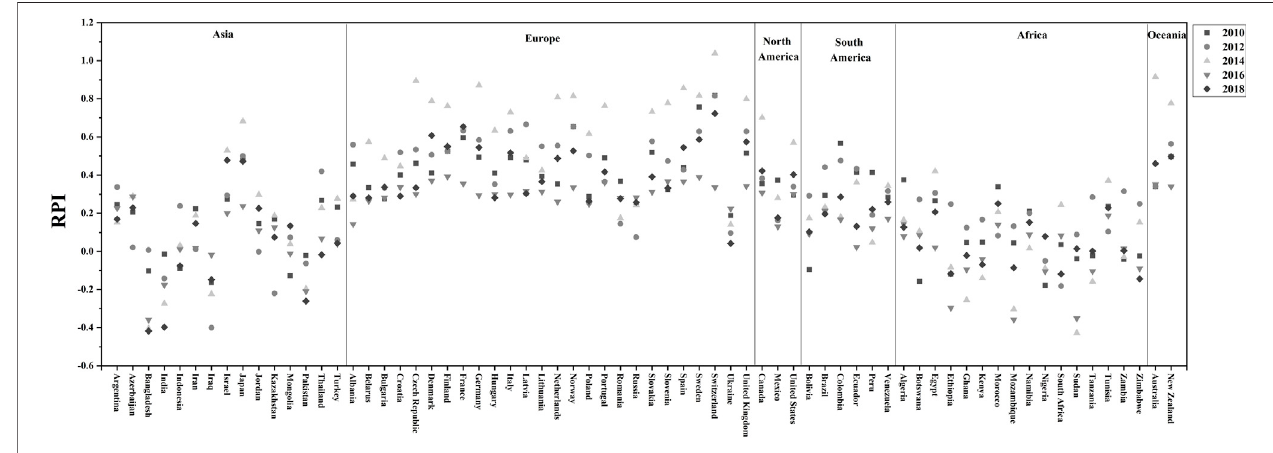
FIGURE 2 | Environmental regulation differences in host countries from 2010 to 2018.